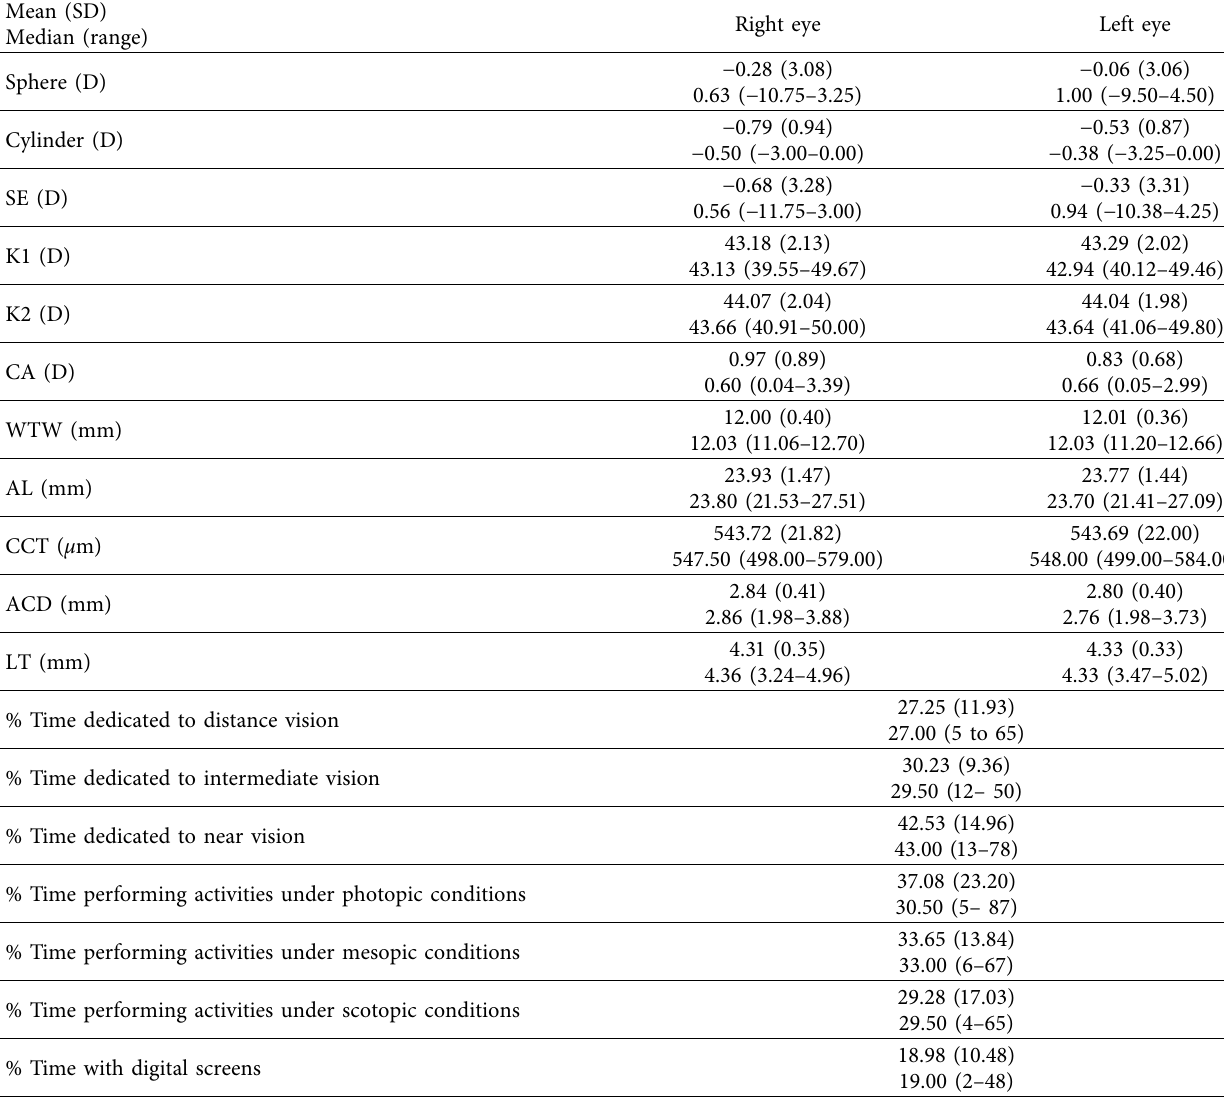
Table 1: Summary of the main clinical data obtained in the sample of patients